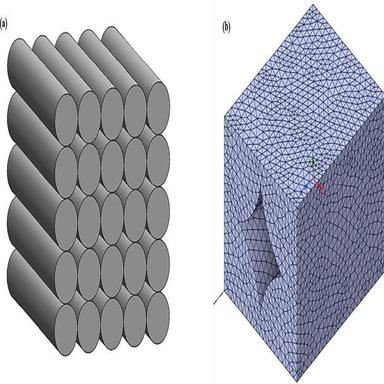
Schematic view of an (a) bead by bead 3D printed part (b) Representative volume element (RVE).